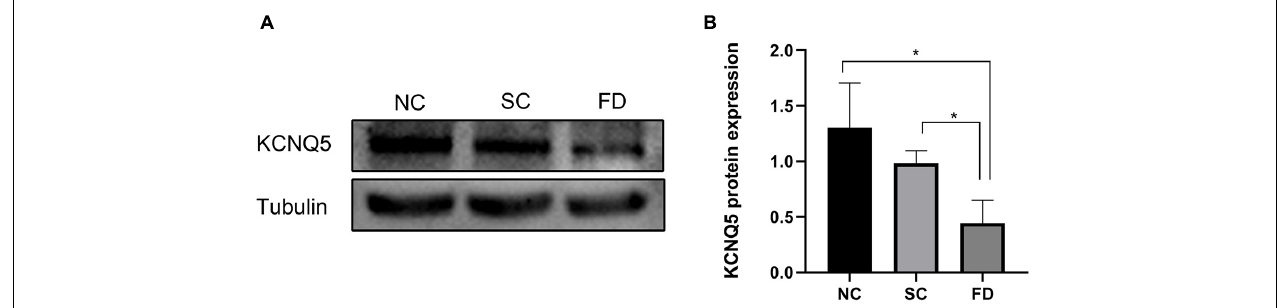
FIGURE 3 | Measurement of KCNQ5 expression at protein levels after 4 weeks of treatment. (A) Showed the western blot electrophoretic bands of each group; (B) showed the statistical results of gray level of the stripe (* P < 0.05).